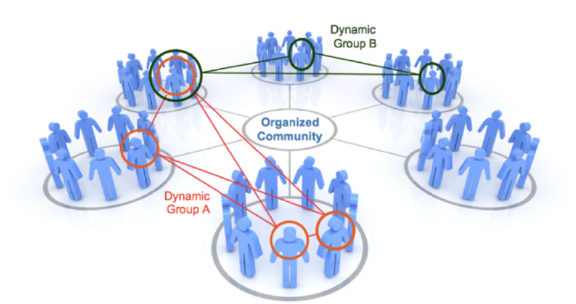
Figure 1. Virtual Organizations as a reference